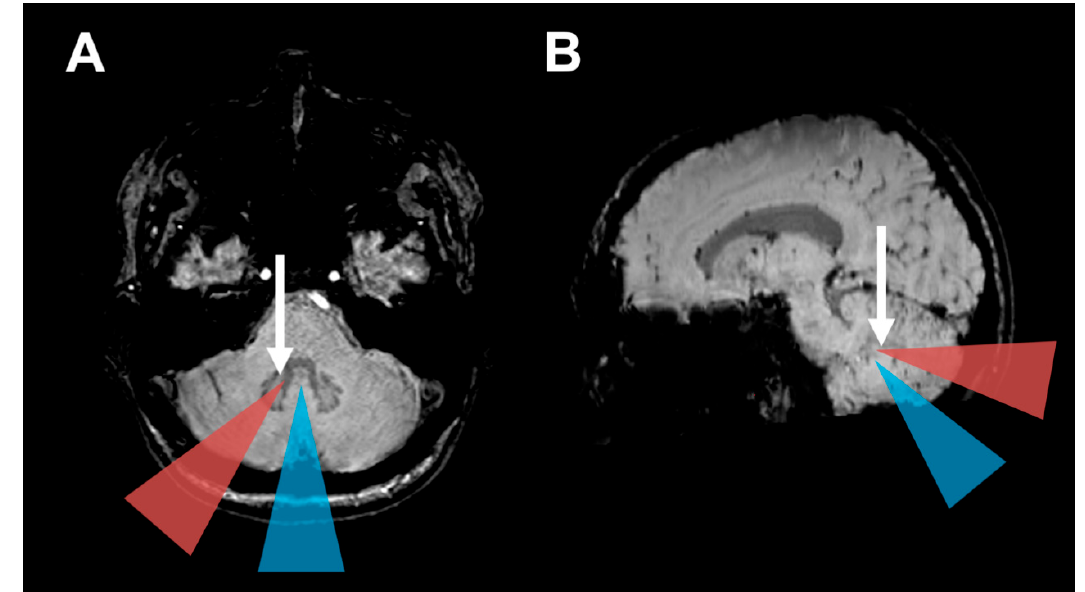
Figure 3. HOD development based on operative approach: ( A ) Axial and ( B ) parasagittal magnetic resonance susceptibility- weighted images (SWI) illustrate the operative approaches investigated in this study. The blue triangles indicate midline approaches (telovelar and transvermian). The orange triangles indicate the paravermal trans-cerebellar operative corridor that frequently led to hypertrophic olivary degeneration in our cohort by injury to the dentate nucleus